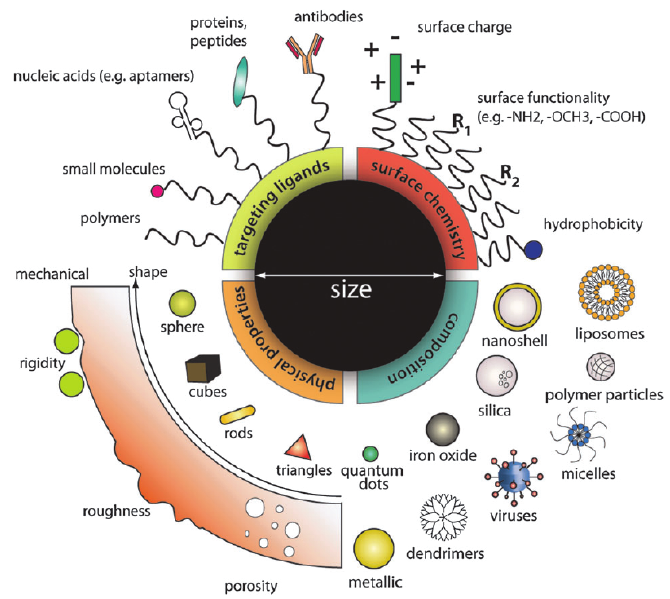
Figure 1. Design of nanoparticle (NP)-based drug delivery platform, according to the size, shape, stiffness (composition), and surface properties of NPs. The figure is adapted from Reference [11] with